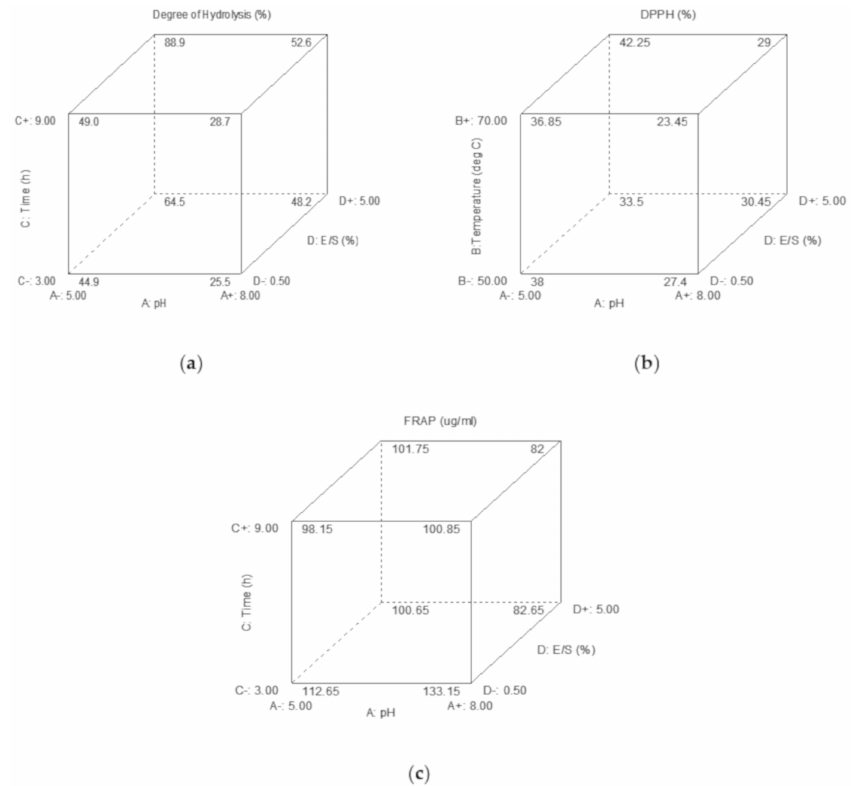
Figure 3. Cube plots showing the interaction of three significant e ff ects on ( a ) the degree of hydrolysis (DH) response, ( b ) 2,2-diphenyl-1-picrylhydrazyl (DPPH) radical scavenging response and ( c ) ferric-reducing antioxidant power (FRAP)